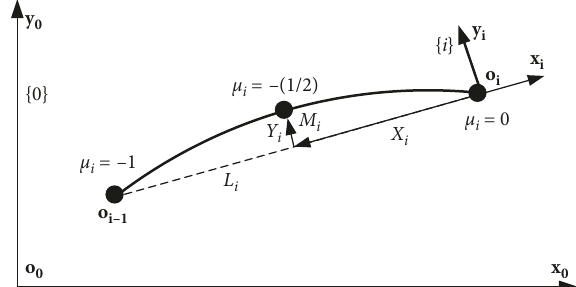
Figure 2: Position of lumped mass M